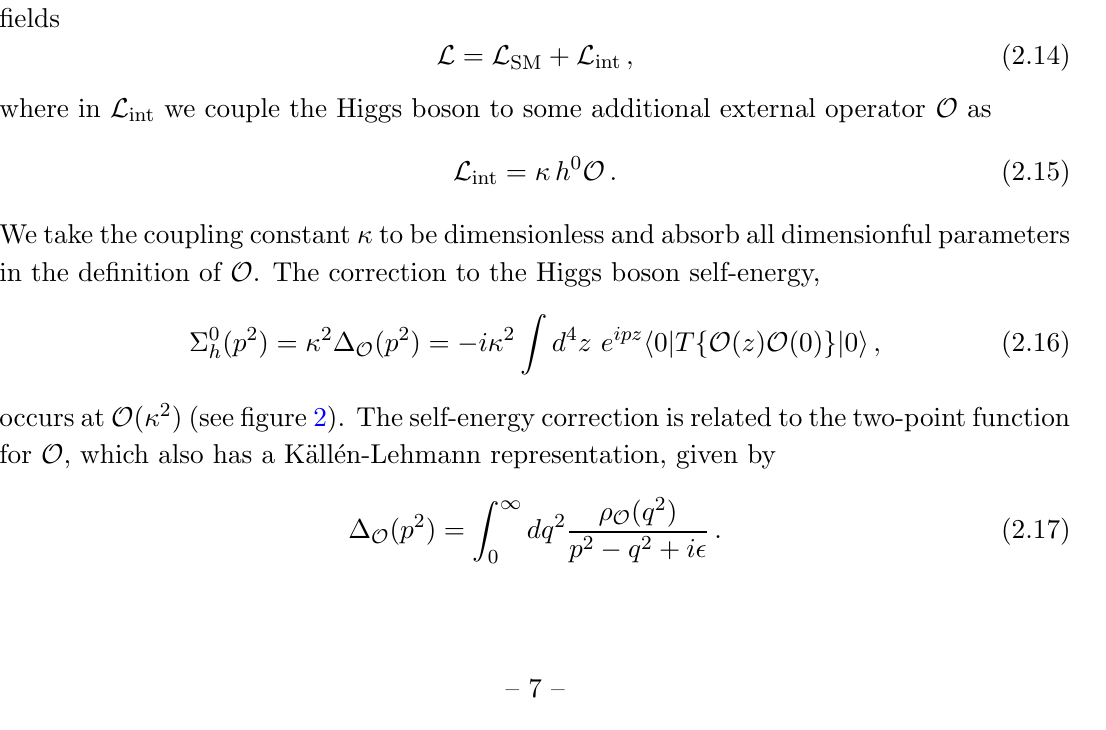
Figure 2 . Higgs self-energy correction from the two-point function of the operator O